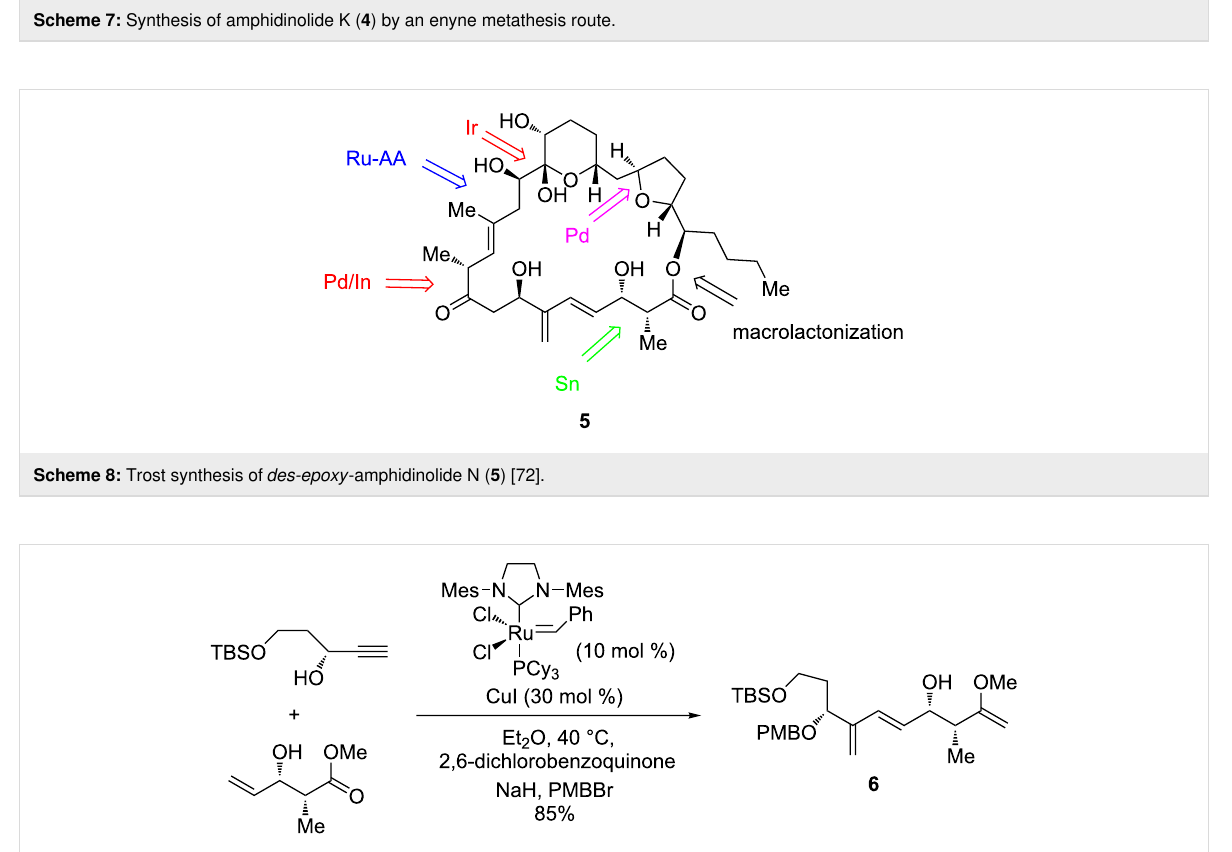
Sn), and a Krische allylation (with Ir) [72]. As special feature